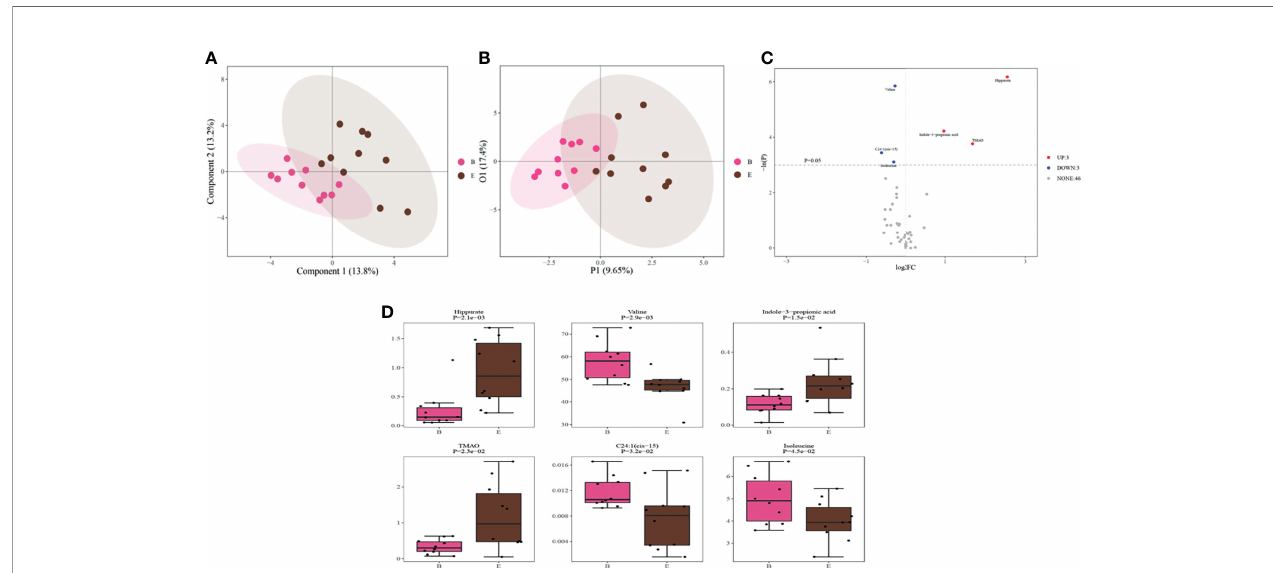
FIGURE 3 | (A). PLS-DA scores re fl ecting metabolic changes in the OSA remission group before and after RYGB surgery; (B) . OPLS-DA scores re fl ecting metabolic changes in the OSA remission group before and after RYGB surgery. (C) Volcano plot of differential metabolites generated by the univariate analysis before and after RYGB surgery; UP indicates the three metabolites that increased after RYGB surgery in the OSA remission group. DOWN indicates the three metabolites that decreased after RYGB surgery in the OSA remission group. NONE indicates the 46 metabolites with no signi fi cant expression differences after RYGB surgery in the OSA remission group; (D) Boxplot of six differential metabolites with statistical signi fi cance generated by univariate analysis. B indicates the preoperative OSA remission group and E indicates the postoperative OSA remission group. PLS-DA, partial least squares-discriminant analysis; OSA, obstructive sleep apnea; OPLS-